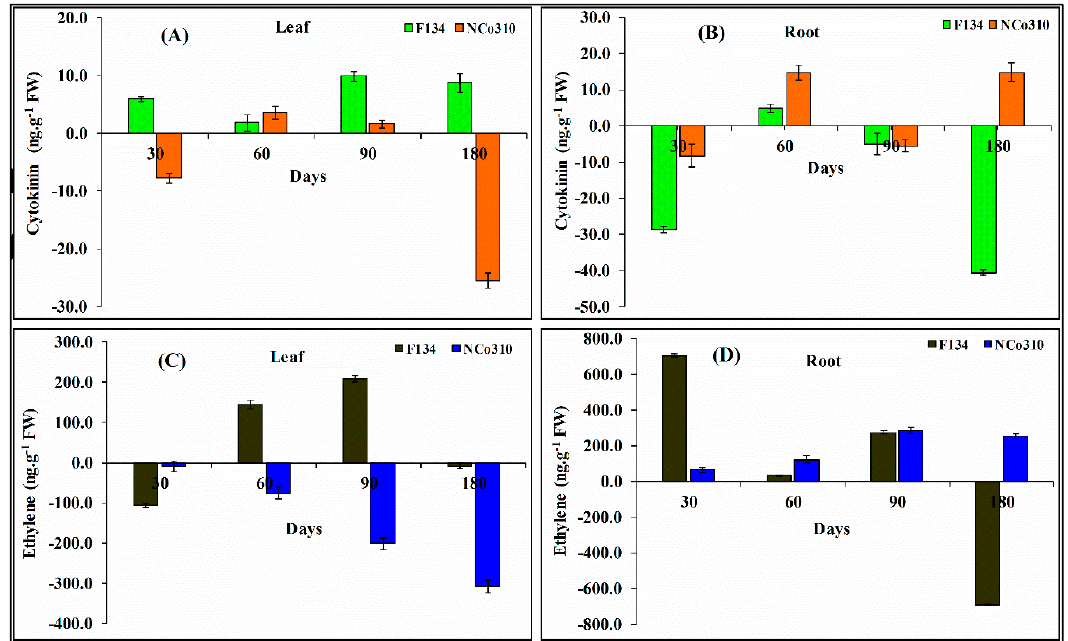
Figure 5. Analysis of phytohormone levels in leaf and root tissues of sugarcane varieties F134 and NCo310 infected with S. scitamineum stress. ( A , B ) Cytokinin and ( C , D ) ethylene. All data points (with the subtraction of their controls) are the mean ± SE ( n = 3).